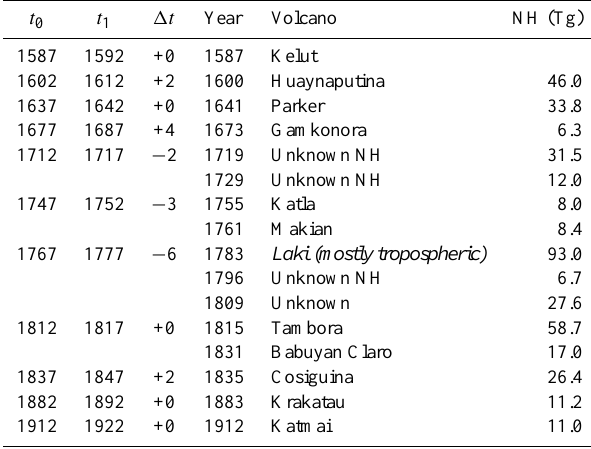
Table 4. Phases of very low reconstructed ELA between 1580 and 1920, and explosive tropical volcano eruptions causing significant aerosol loading in the Northern Hemisphere (NH). The 1t row indi- cates the number of years of delay (+) or advance ( − ) with respect to the eruptions. The estimated NH stratospheric aerosol loading (based on ice cores, Gao et al., 2008) is given in the last column (data from Table 1 in Arfeuille et al.,